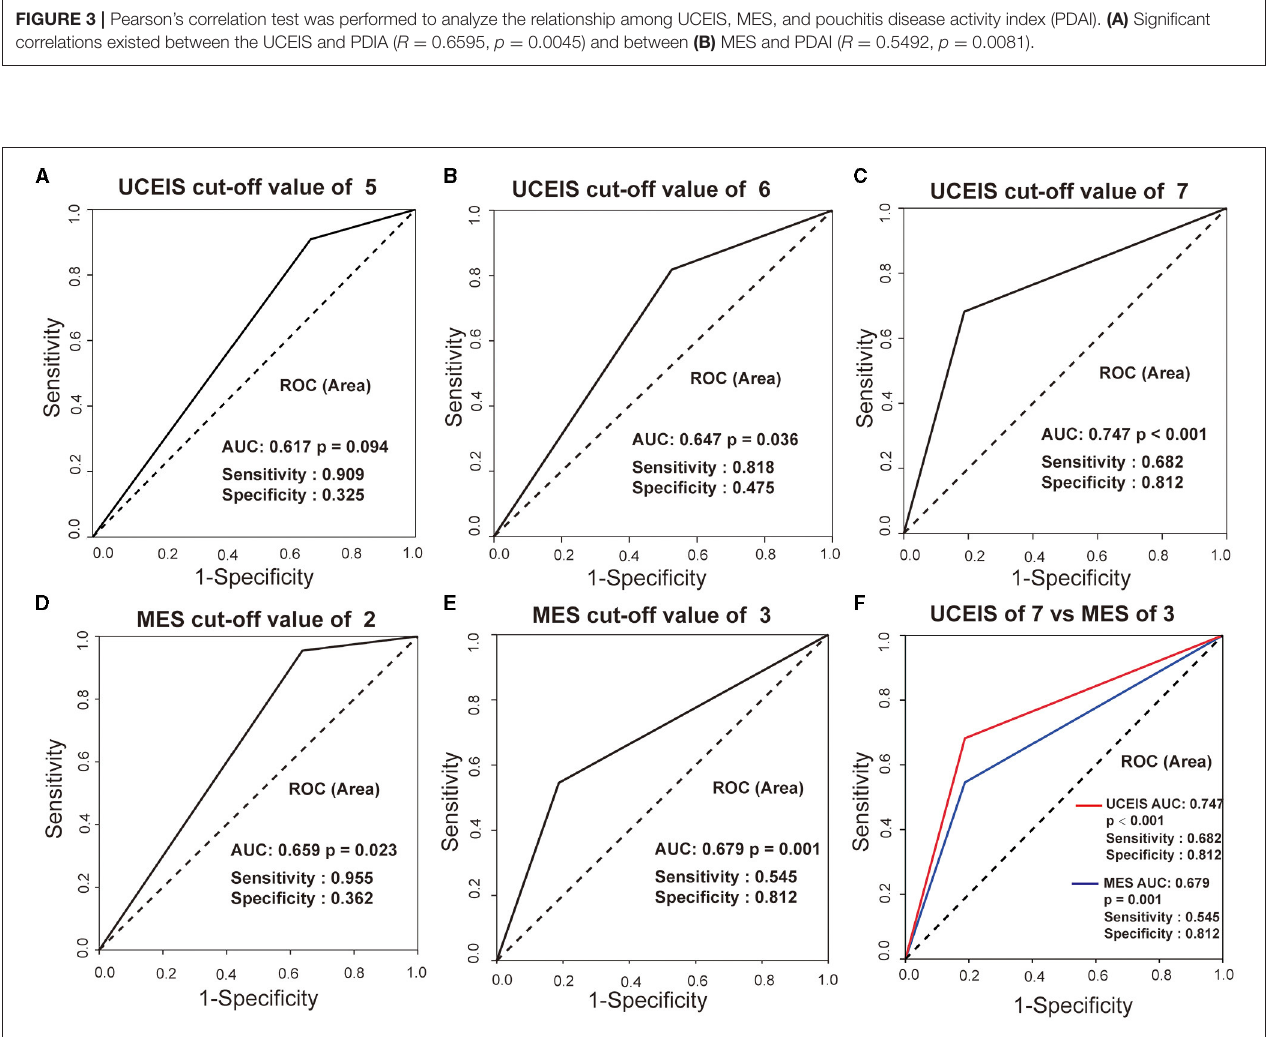
FIGURE 4 | Receiver-operating characteristic (ROC) curves of UCEIS and MES in predicting pouchitis in patients with ulcerative colitis (UC). UCEIS had the most significant AUC of 0.747 with a sensitivity of 68.2%, and a specificity of 81.2% with a cut-off value of 7 (A–C, F) , while MES = 3 had an AUC of 0.679 with a sensitivity of 54.5% and specificity of 81.2% (D, E, F)